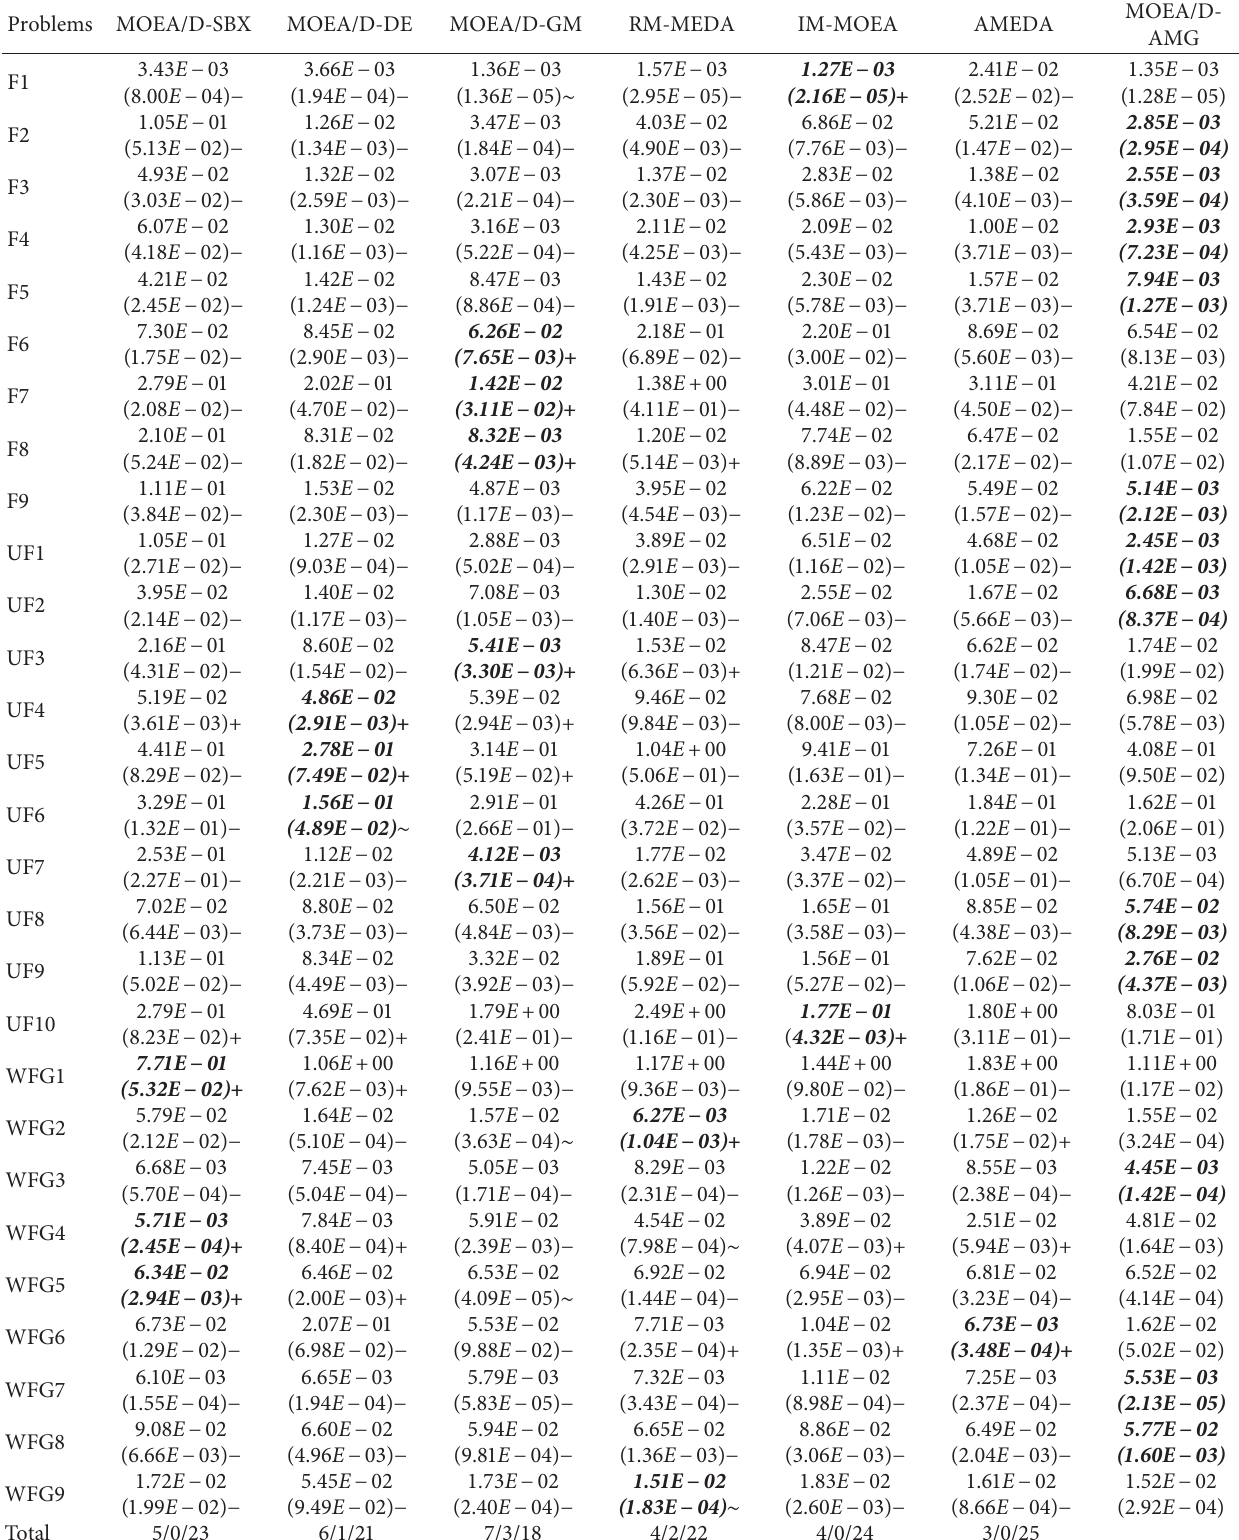
Table 1: Performance comparison of MOEA/D-SBX, MOEA/D-DE, MOEA/D-GM, RM-MEDA, IM-MOEA, AMEDA, and MOEA/D- AMG in terms of the average IGD values and standard deviation on F, UF, and WFG